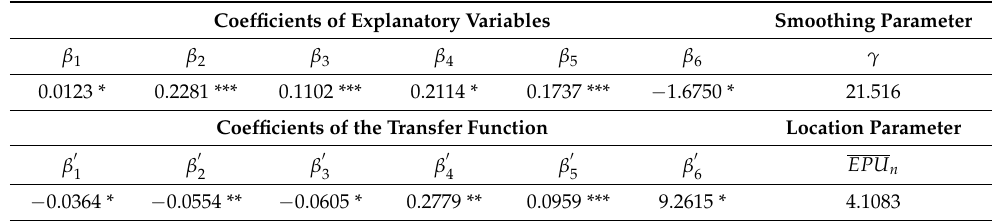
Table 3. Results of model parameter